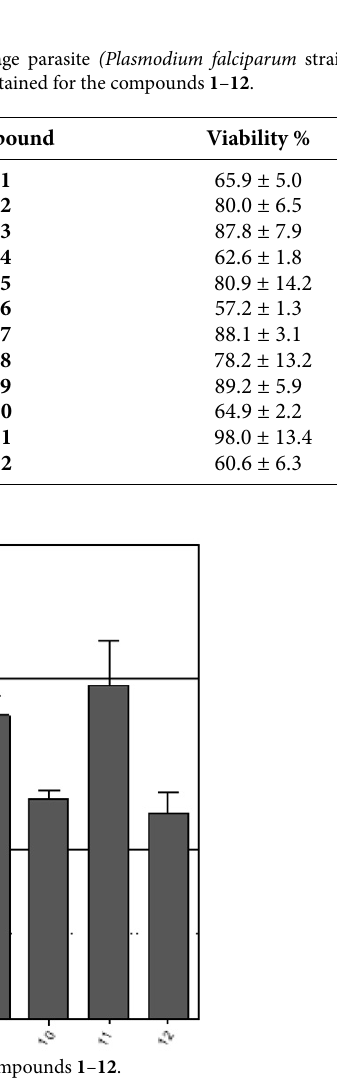
Figure 7. 2D representation of 1-(3-bromobenzoyl)-3-[2-({[(3-bromophenyl)formamido]methanethioyl}amino)phenyl]thiourea ( 10 ) in the HIV-1 protease binding site.